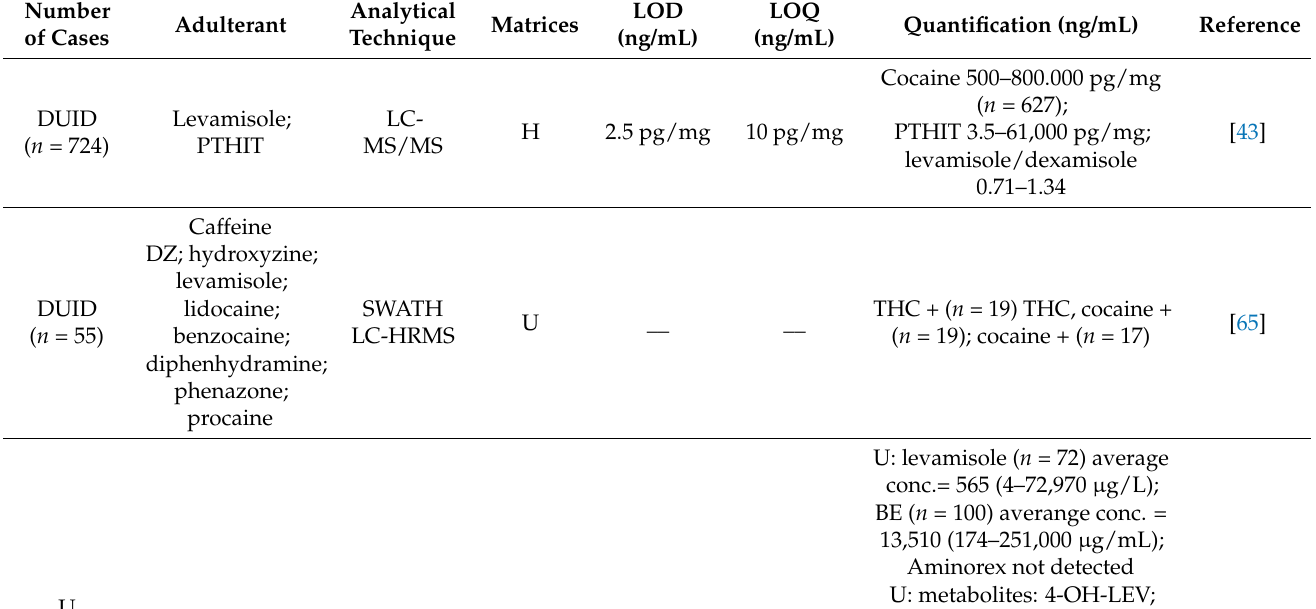
Table 3. Number of authentic cases of adulterated cocaine, heroin, and new psychoactive substances (NPS) intoxications reported in the literature between 2017 and